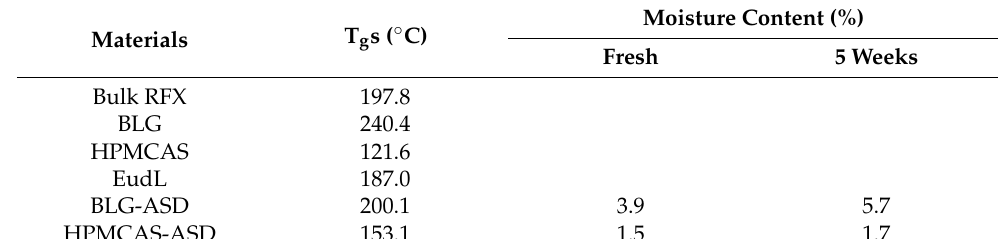
Table 1. T g s and moisture contents of different materials.